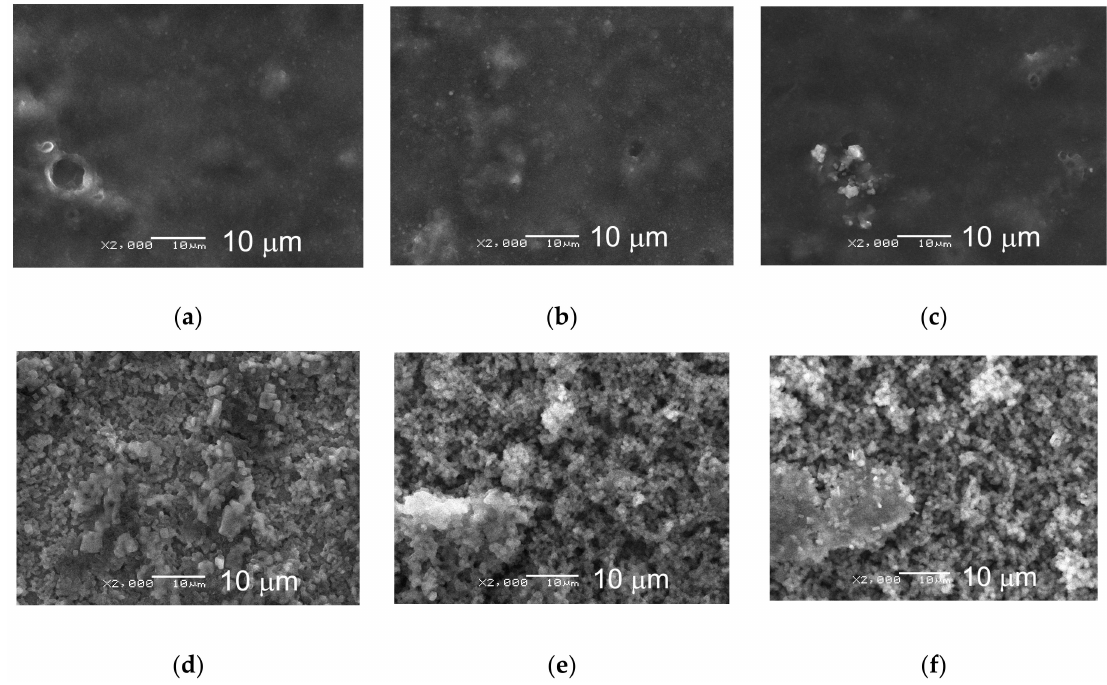
Figure 5. SEM surface morphologies of ( a ) polished, ( b ) 400 ◦ C, ( c ) 600 ◦ C heat-treated CP-Ti specimens after immersion with no UV light irradiation, ( d ) polished, ( e ) 400 ◦ C, ( f ) 600 ◦ C heat-treated specimens after immersion with UV light